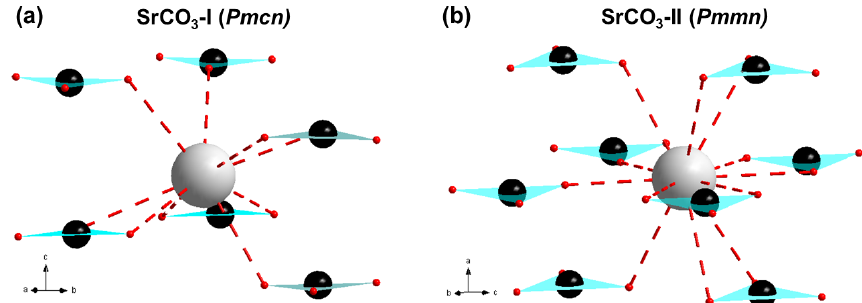
Figure 8. A fragment of SrCO 3 -I (a) and SrCO 3 -II (b) crystal structure at ambient pressure and at 26.3GPa, respectively, showing Sr 2 + ions (light grey sphere) surrounded by six CO 2 − anions in the aragonite structure, whereas Sr 2 + ions in the post-aragonite structure are 3 surrounded by eight triangular CO 2 − anions (C: dark grey spheres; O: red 3